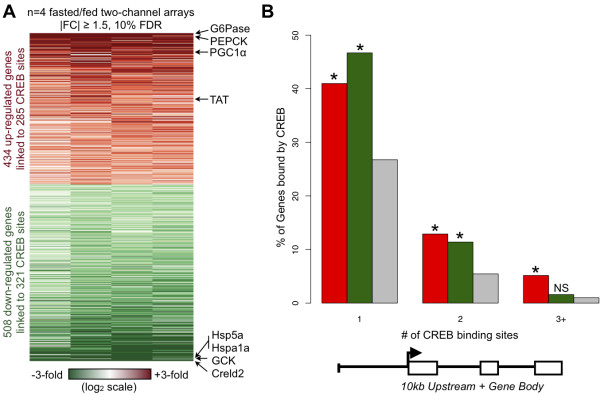
Enrichment of CREB binding around fasting-responsive genes. A) Heatmap of genes called as differentially expressed in fasted versus re-fed liver microarray experiment. Known fasting-inducible CREB targets are shown on top right. Selected feeding-inducible and ER stress genes are shown at bottom right. Number of genes and associated CREB sites are shown on left. B) For each gene category (fasting-induced in red, fasting-repressed in green, and all genes on the microarray in gray), we computed the percentage of genes containing 1, 2, or 3+ high-confidence CREB binding sites anywhere in the 10 kb TSS upstream region or the gene body (including introns). ~60% of regulated genes (both fasting-induced and fasting-repressed) have at least one CREB binding site by this criteria, while 33% of all genes on the array can be associated with at least one CREB binding site. *p-value < 1E-5 by Fisher’s Exact Test versus gray bars. NS indicates p-value > 0.05. A full listing of differentially expressed genes and associated CREB binding is provided in Additional file 2.